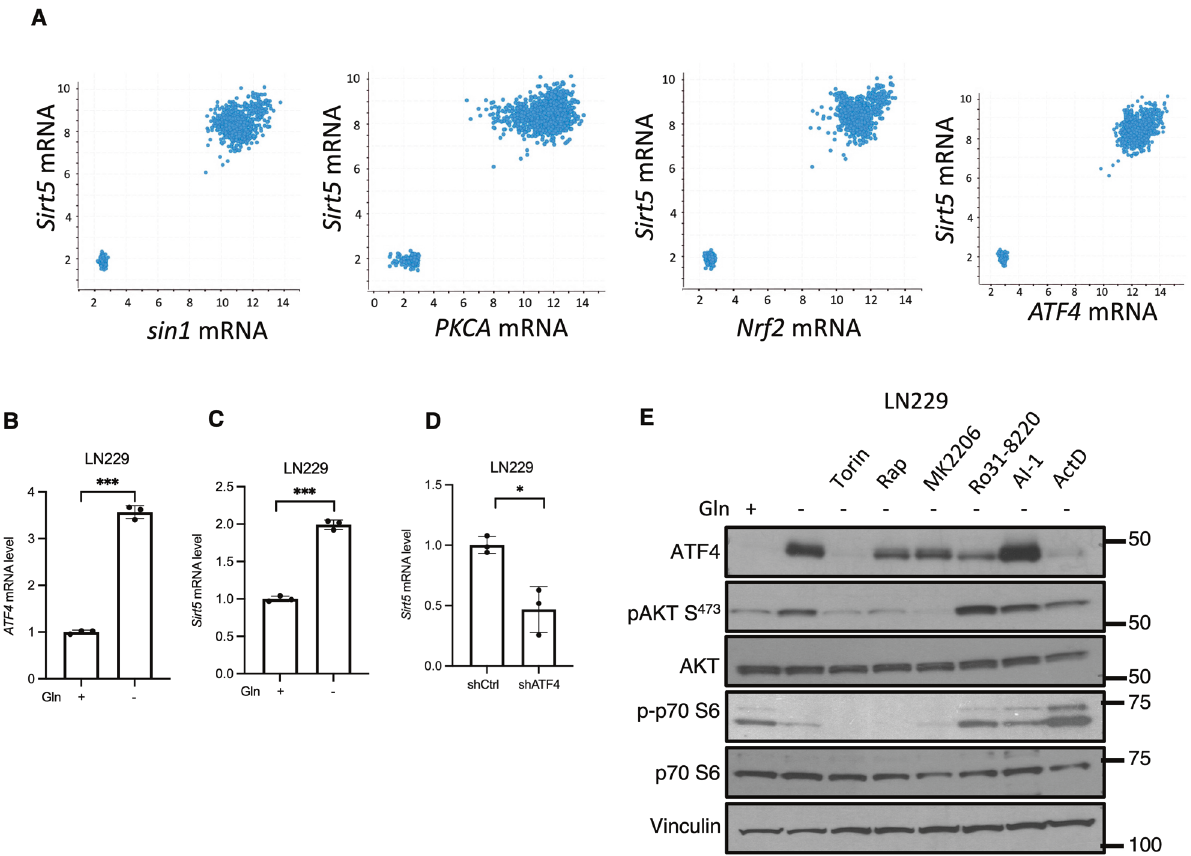
Fig. 7 Evidence for the mTORC2-PKC-Nrf2-ATF4-Sirt5 pathway in brain cancer. A Scatter plots showing that Sirt5 mRNA levels correlate with sin1 (Spearman: 0.27 Pearson: 0.96), PKCA (Spearman: 0.37 Pearson: 0.92), NRF2 (Spearman: 0.23 Pearson: 0.96) and ATF4 (Spearman: 0.38 Pearson: 0.97) mRNA levels in brain cancer. Data are from the TGCA brain cancer dataset. B RT-qPCR quanti fi cation of ATF4 mRNA in LN229 cells cultured ± glutamine in serum free medium for 24 h. Data shown are representative of two independent experiments and expressed as means ± SD for triplicate measurements. C RT-qPCR quanti fi cation of Sirt5 mRNA in LN229 cells cultured ± glutamine in serum free medium for 24 h. Data shown are representative of two independent experiments and expressed as means ± SD for triplicate measurements. D RT-qPCR quanti fi cation of Sirt5 mRNA in control and ATF4 KD LN229 cells cultured in glutamine free medium for 24 h. Data shown are representative of two independent experiments and expressed as means ± SD for triplicate measurements. E Western blot analysis of WCL from LN229 cells treated with Torin1 (500 nM), Rapamycin (50 nM), MK2206 (5 μ M), Ro31-8220 (1 μ M), AI-1 (10 mM) or ActD (1 μ g/mL) in serum/glutamine free medium for 24 h. Blots are representative of two independent